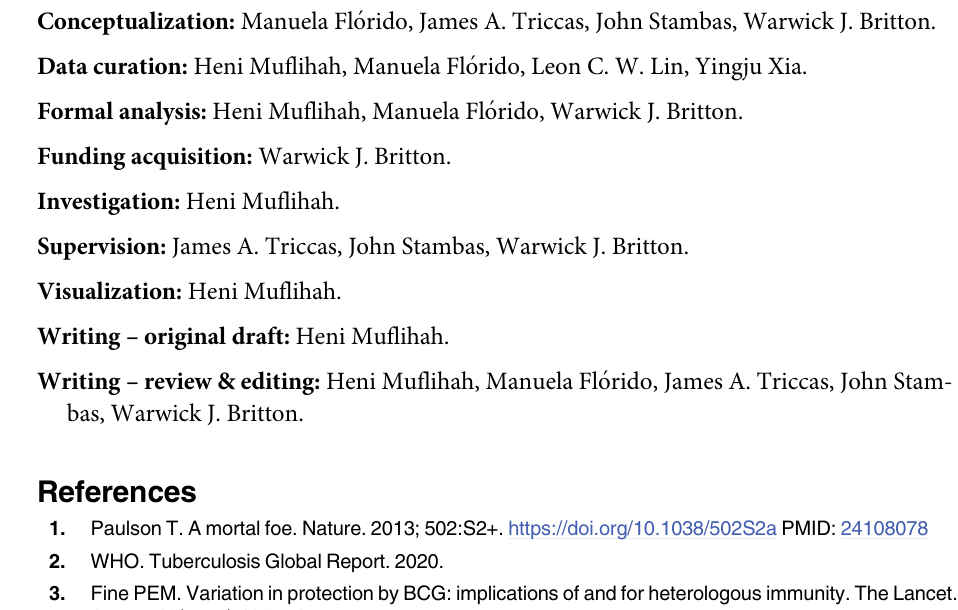
S3 Fig. Cytokine production by p25-specific CD4 + T cells in the spleen after M . tuberculosis challenge. C57BL/6 mice (n = 5) were vaccinated simultaneously with BCG s.c. and PR8-p25 i.n., and challenged with M . tuberculosis as in Fig 1A. The splenocytes were stimulated with p25 antigen and then analysed for intra-cellular cytokine production by flow cytometry. The frequency of p25-specific CD4 + T cells secreting IFN- γ , IL-2 and TNF were detrermined at (A) two, (B) four, and (C) twenty weeks after challenge. Data are the means ± SEM. Statistically significant differences between groups were determined by one-way ANOVA ( � ) or Kruskal- Wallis ( # ) ( � p < 0.05; �� p < 0.01). S4 Fig. Antigen-specific T cell responses following BCG boosting with X31-p25 and PR8-p25. (A) Experimental design for BCG boosting with X31-p25 and PR8-p25 rIAVs. C57BL/6 mice (n = 4–6) were vaccinated with 5x10 5 CFU BCG s.c., vaccinated 12 weeks later with 10 4 PFU X31-p25 i.n. and then were boosted a second time at 18 weeks with 20 PFU PR8-p25 i.n. Other groups were vaccinated with BCG alone, the two rIAVs alone, or were left unvaccinated and antigen-specific T cell responses were assessed four weeks after the last vac- cination. ELISpot analysis of IFN- γ producing T cells in the (B) lungs and (C) spleen following 18 hour stimulation with the relevant antigens. (A) The frequency of p25-specific CD4 + T cells in the (D) lungs and (E) spleen producing individual cytokines or combinations of IFN- γ , IL- 2, and TNF were analysed by ICS flow cytometry using Boolean gating. Data are the means ± SEM. Statistically significant differences between groups were determined by one-way ANOVA ( � ) or Kruskal-Wallis ( # ) ( � p < 0.05; �� p < 0.01; ��� p < 0.001; ���� p < 0.0001).